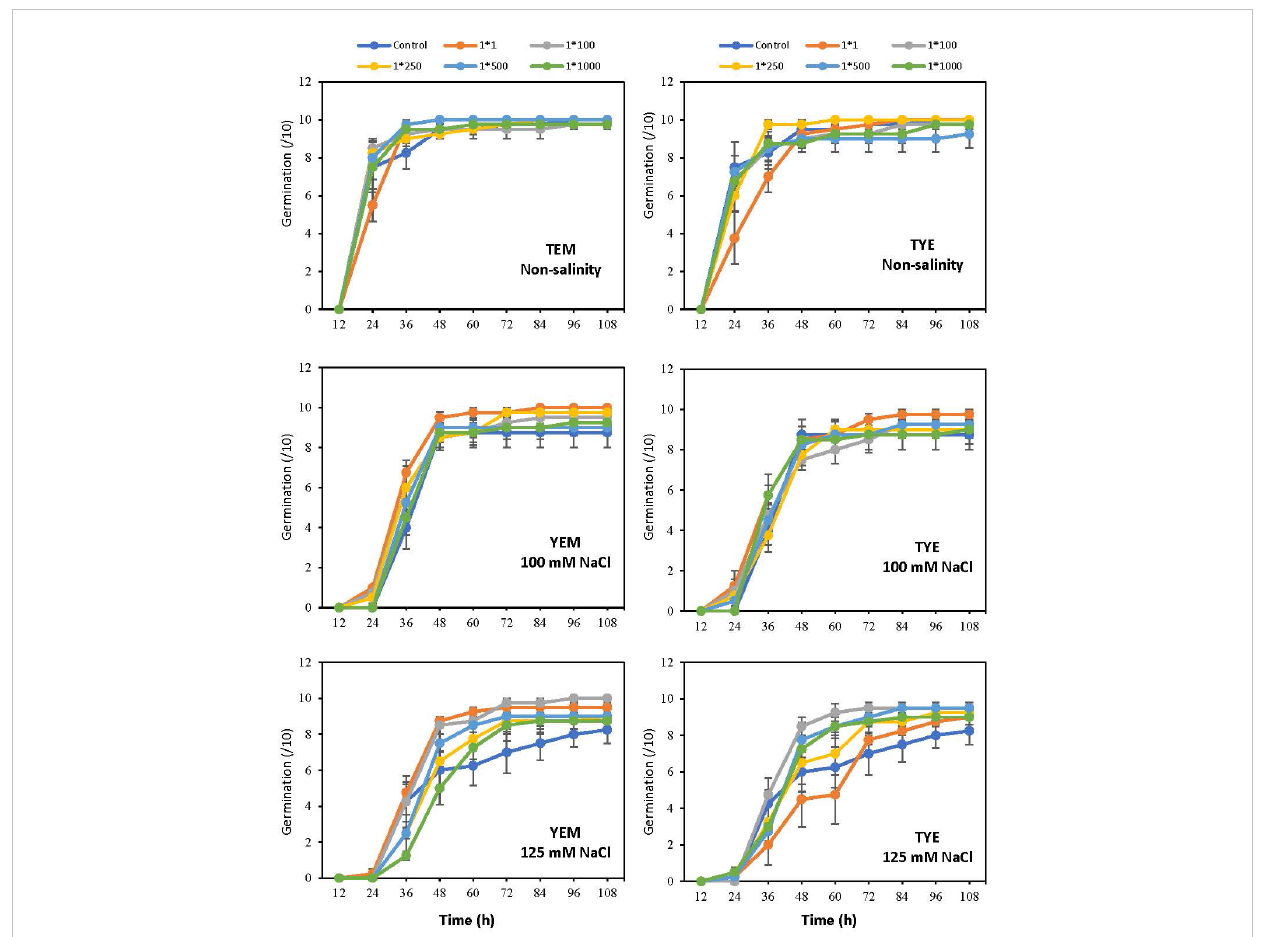
FIGURE 3 Changes in seed germination for soybean in response to salinity and dilutions of Devosia sp. YEM(B)-CFS and TYE(B)-CFS. Values represent the means of four replicates ± SD. 1:1, 1:100, 1:250, 1:500 and 1:1000 = 1 mL Devosia sp. CFS and 1, 100, 250, 500 and 100 mL distilled water respectively.